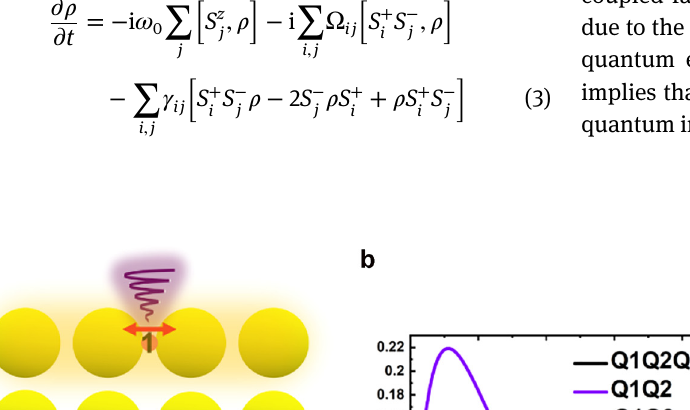
Figure 6: Schematic of the generation of quantum entanglement source. (a) Schematic diagram of the quantum entanglement with XP-dipole light. Four quantum dots are put in the middle of the four edges and number by Q1, Q2, Q3 and Q4 respectively. (b). Calculated total con- currence function (black), the concurrence function between Q1 and Q2 (purple) and the concurrence function between Q1 and Q3